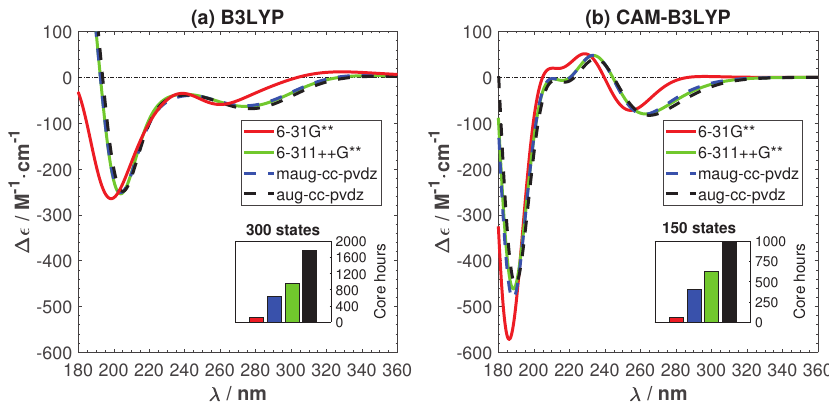
Figure 3. (main figures) The effects of basis sets and exchange correlation-functional on the ECD spectrum of a single snapshot structure and (inset figures) the related cpu time costs. ( a ) B3LYP; ( b ) CAM-B3LYP.